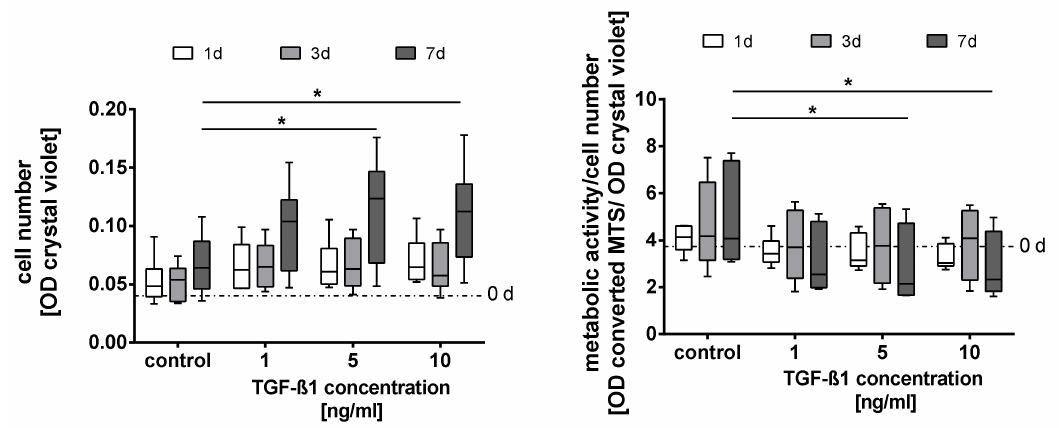
Figure 1. Cell number ( a ) and metabolic activity per cell number ( b ) after exposure to di ff erent concentrations of TGF-ß1 on day 0, 1, 3, and 7 (cell number quantified with crystal violet staining, metabolic activity measured via a tetrazolium salt conversion assay). Data presented as box plots with medians, interquartile ranges and minimum / maximum values ( n = 6). Since the dataset did not represent a Gaussian distribution (Shapiro-Wilk test), the statistical analysis was performed using the Two-Way variance analysis test ANOVA followed by Dunnett’s multiple comparison post hoc test. * p ≤ 0.05. Comparison with the control.